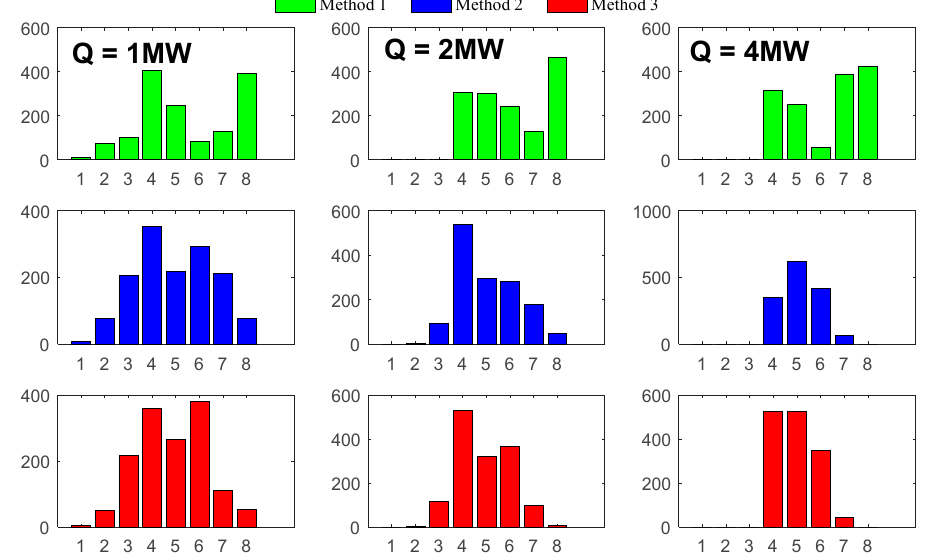
Figure 9. Comparison curve of Δ P G and SOE with three methods under different δ . Table 4. Assessment criteria under different Q.